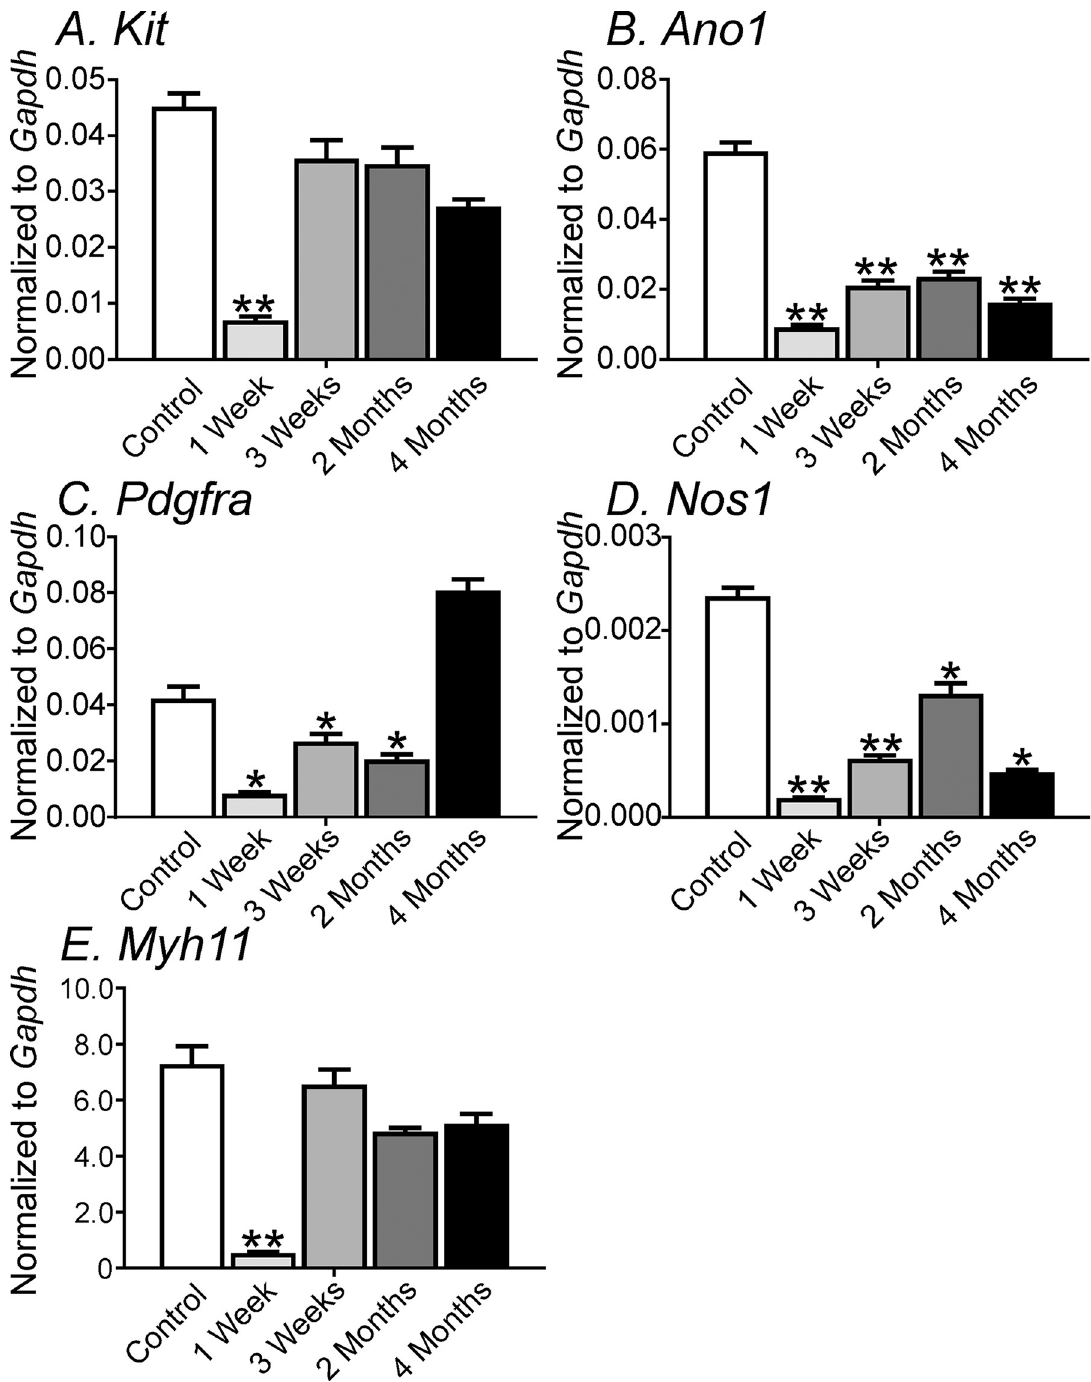
Fig 10. Changes in gene transcripts of gastric tissue following VSG. Panels A-E, Changes in Kit (ICC), Ano1 (ICC), Pdgfra (PDGFR α ), Nos1 (nNOS; nitric oxide synthase inhibitory nerves), Myh11 (smooth muscle myosin), in control (0 week), 1 week, 3 weeks, 2 months, and 4 months, respectively from site #1 post-VSG. Kit , Ano1 , Pdgfra Nos1 and Myh11 transcripts were markedly decreased in antral muscles 1-week post-VSG. Cell-specific gene transcripts showed partial recovery over the 4-month examination period. � P < 0.05 and �� P <